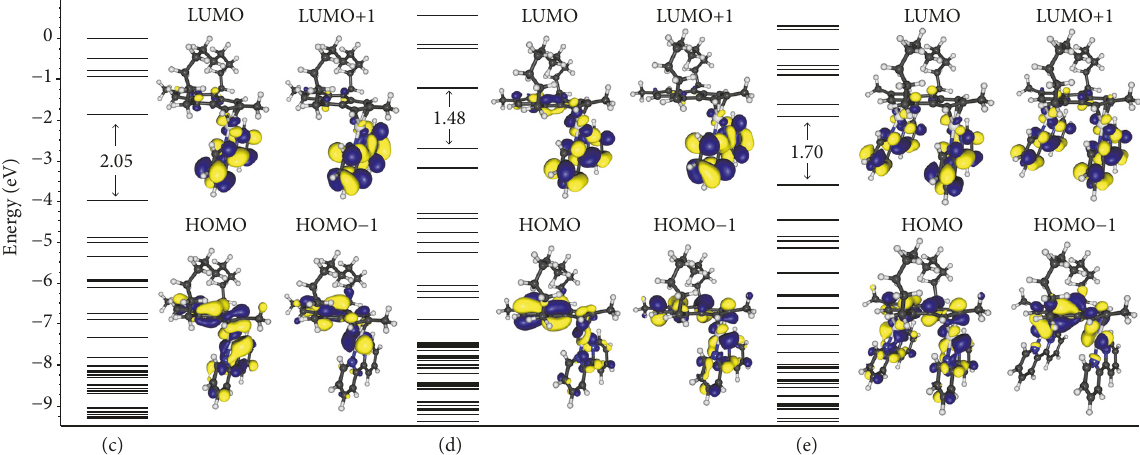
Figure 2: Compounds with Rh: (c) neutral monometallic, (d) monometallic monoanion, and (e) bimetallic systems with L = bipy and R = CH 3